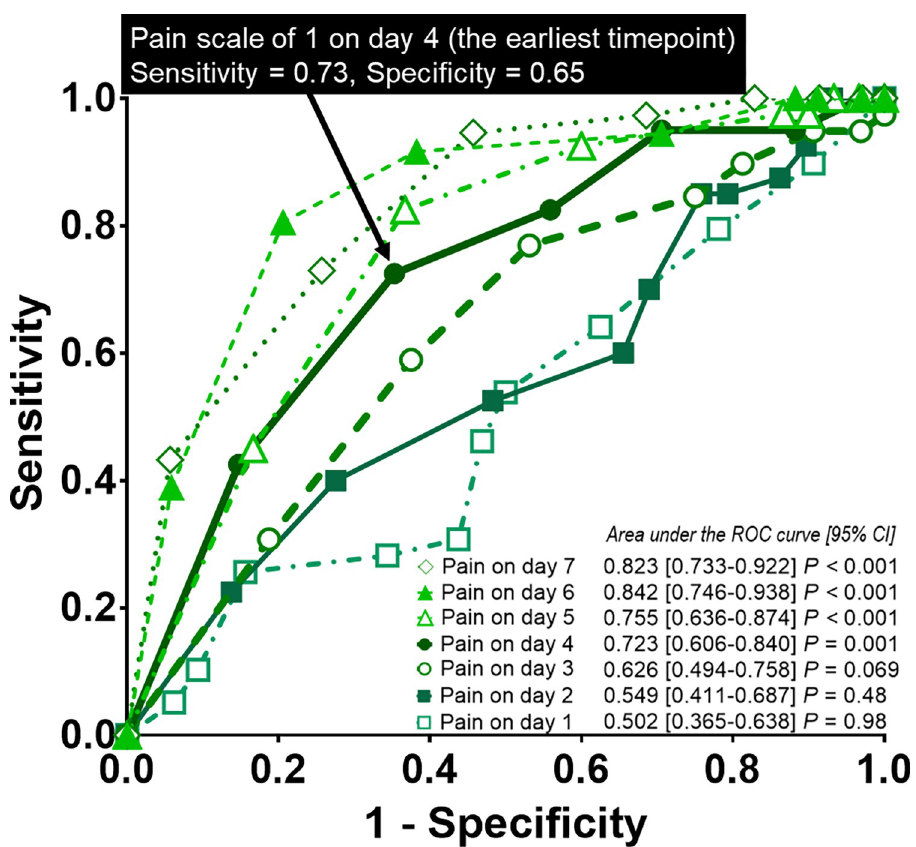
Fig 5. The receiver operating characteristic (ROC) curves of pain severity level on days 1, 2, 3 and 4 for predicting recovery of pain to mild level at the time of the first post-discharge clinic visit. The area under the ROC curve of pain severity level on day 1, 2, 3, and 4 were 0.502( P = 0.98), 0.549 ( P = 0.48), 0.626 ( P = 0.069), and 0.723 ( P = 0.001), respectively. A pain scale value of 1 on day 4 was determined as the best cut-off level to predict symptom recovery to a mild level by the first post-discharge clinic